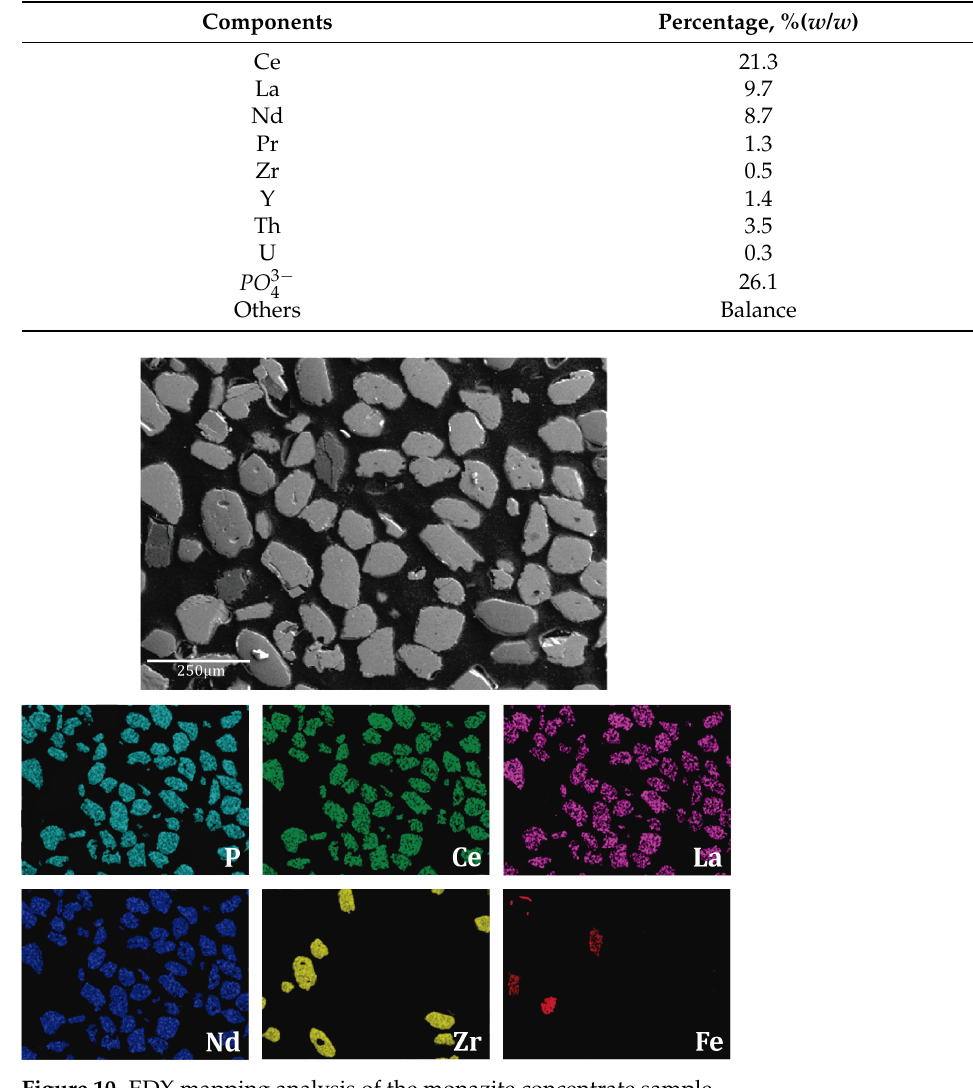
Figure 10. EDX mapping analysis of the monazite concentrate